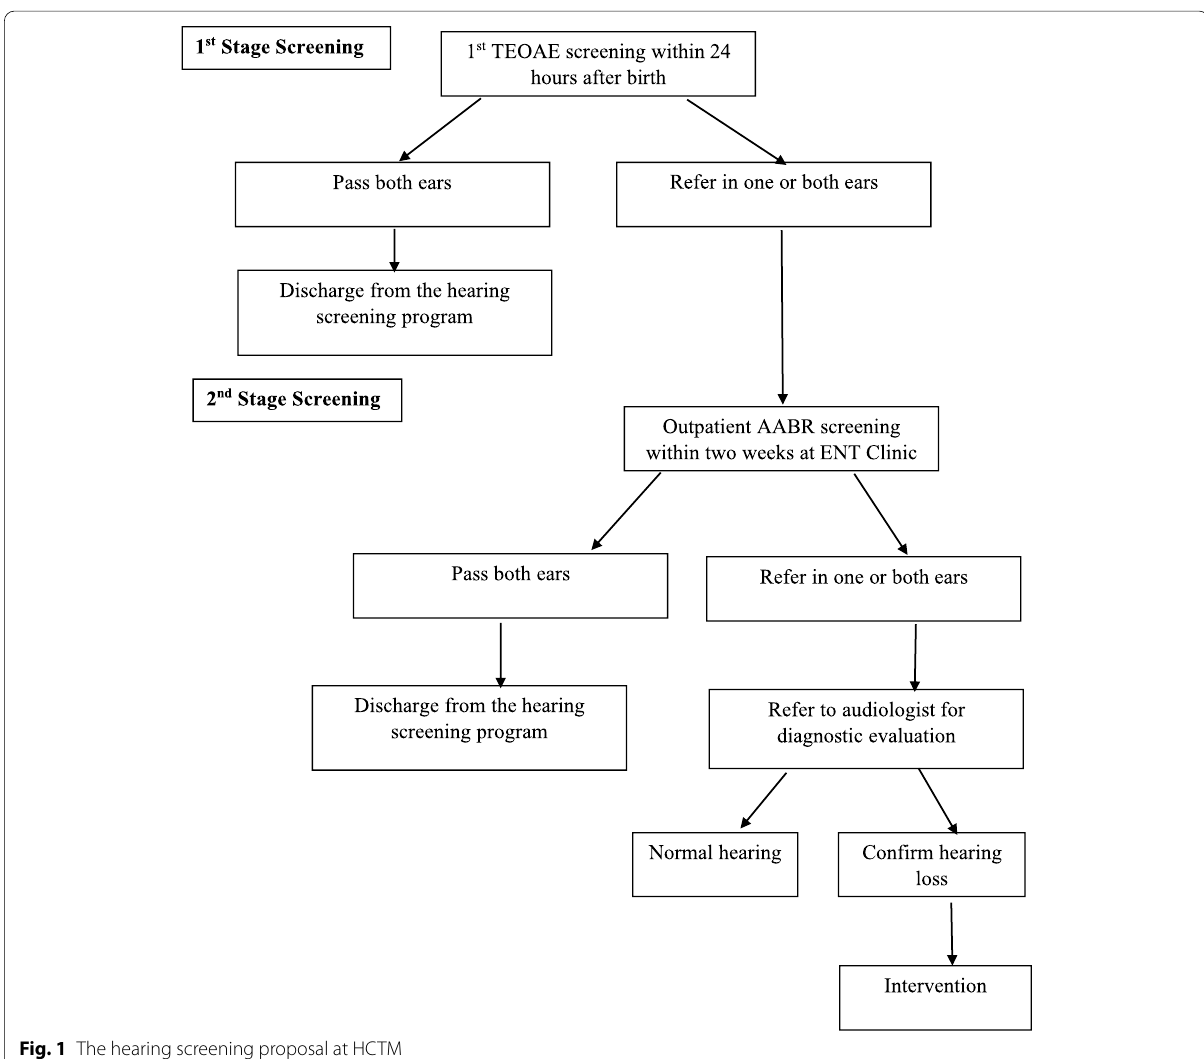
Fig. 1 The hearing screening proposal at HCTM